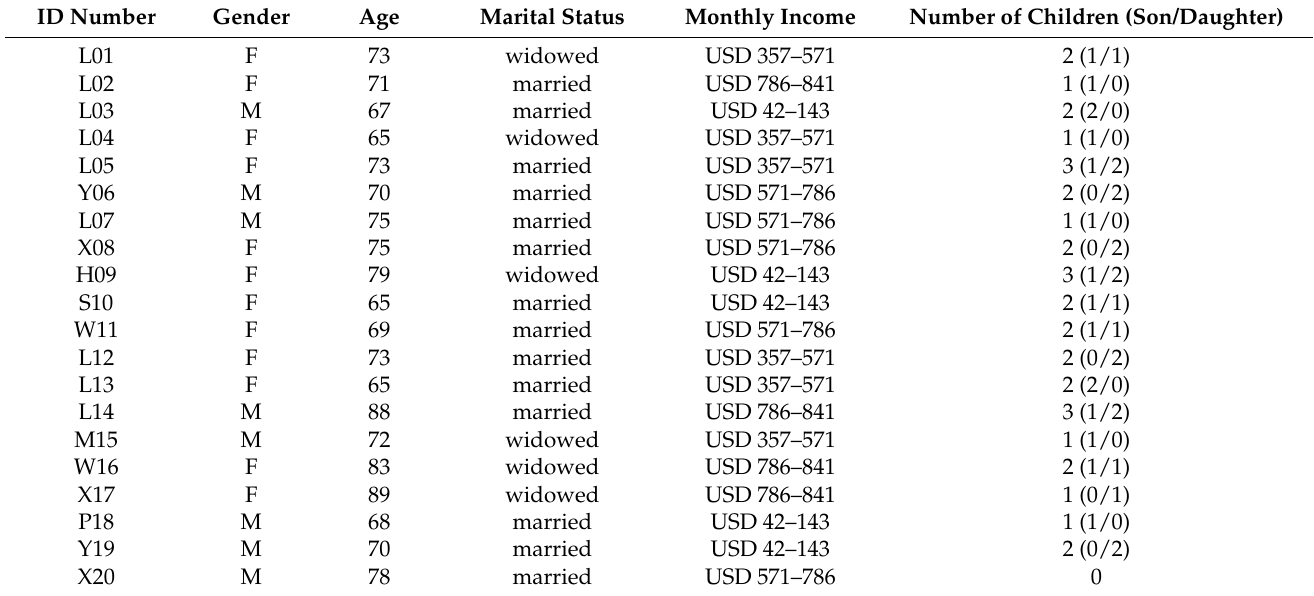
Table 2. A summary of the sample